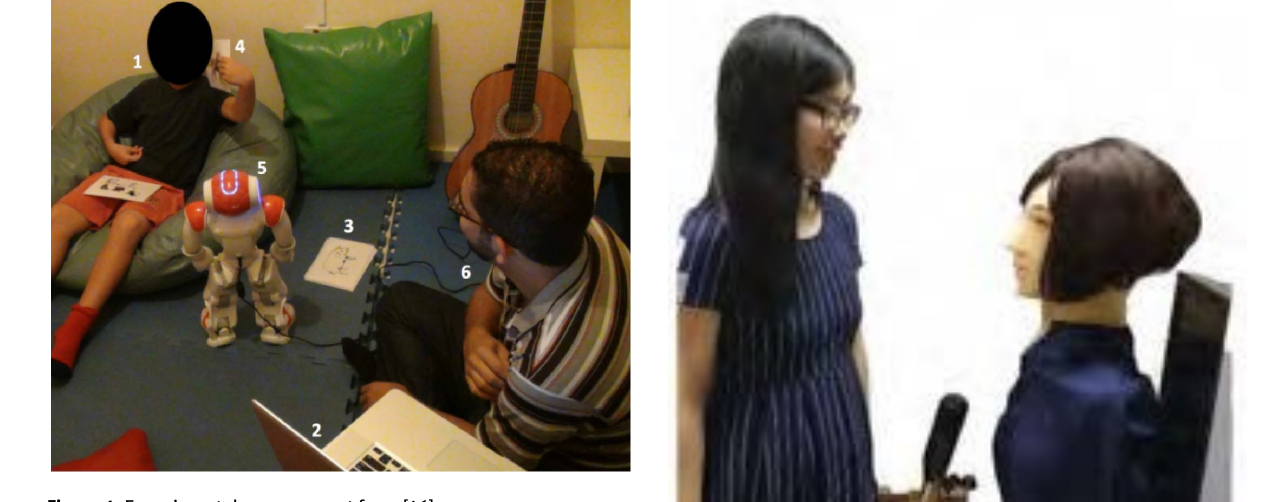
Figure 1: Experimental arrangement from [16].